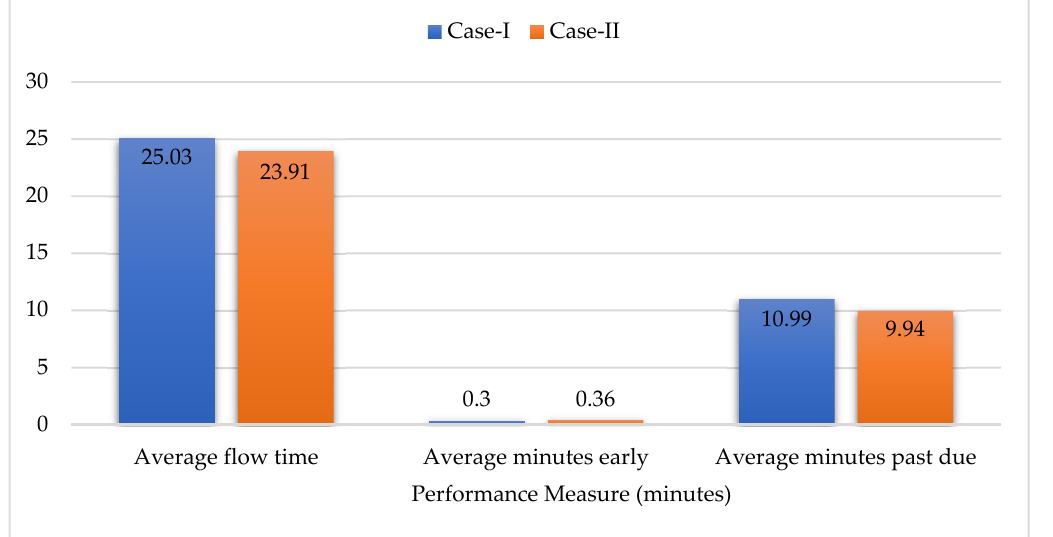
Figure 7. Comparison of the performance measures for Case-I and Case-II using the EDD rule.